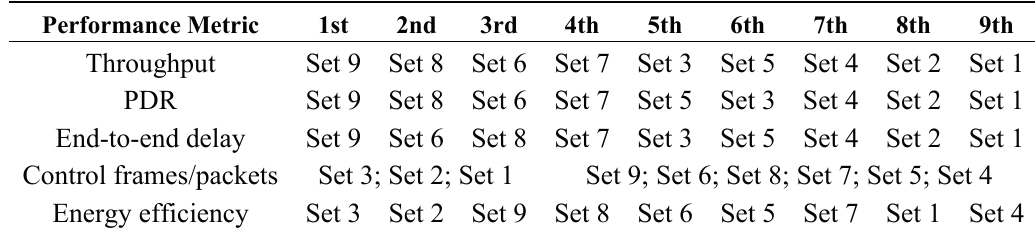
Table 5. Performance ranking.